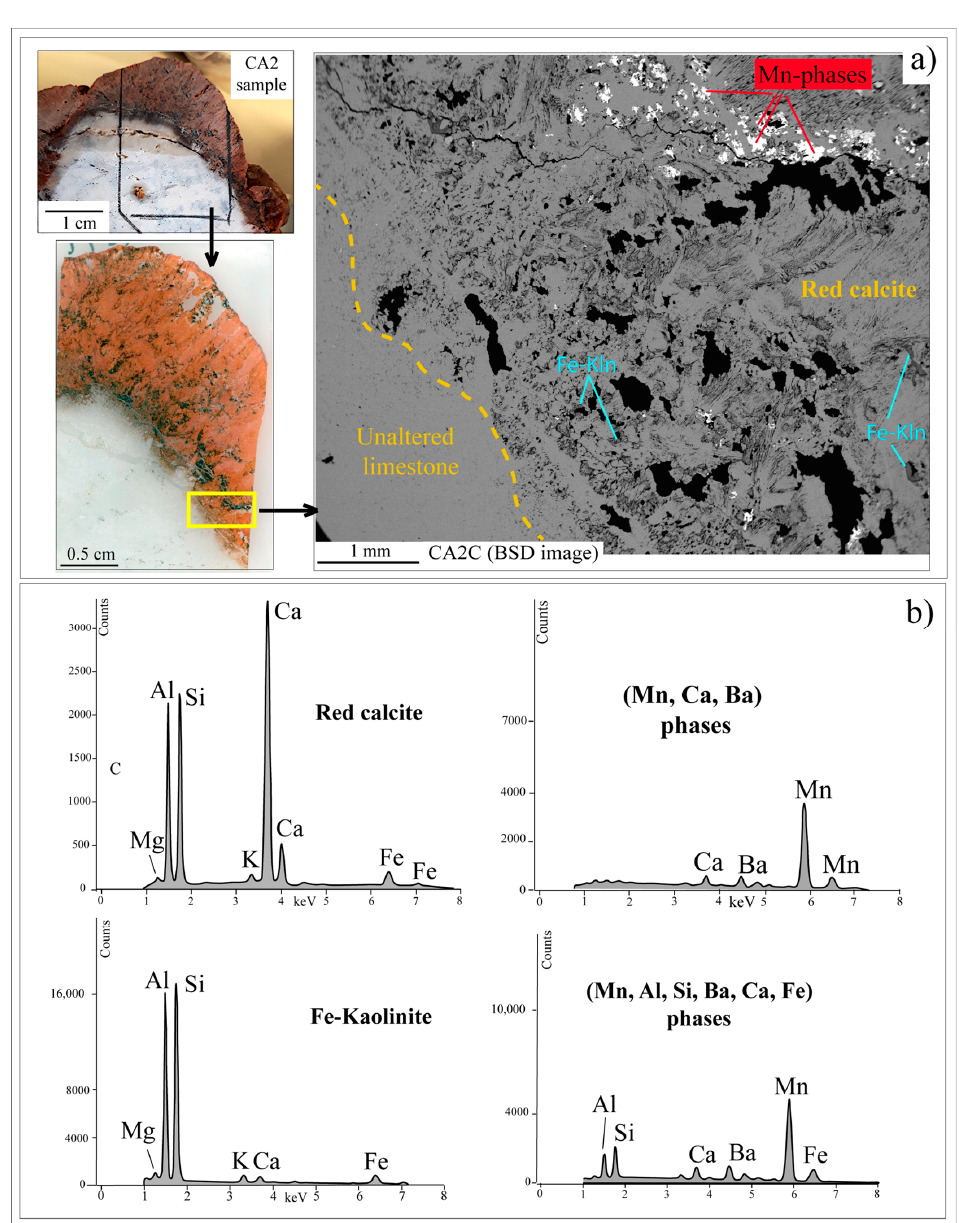
Figure 5. ( a ) Macroscopic image of red incrustation and relative thin section; on the right, a BSD-SEM image; ( b ) Qualitative analyses of some mineral phases in the red incrustation. The centimetric nodules are essentially made up of red calcite with radial growth (Figures 3b and 4c). Small angular grains of quar tz and feldspar are interspersed among calcite fi bers; locally, zircon crystals and some lithic fragments in which a ghost porphyritic texture can be glimpsed (Figure 4c–f), are widespread between them. Some typical nodules were observed under SEM. The structure of red nodules is radial, formed by impure red calcite fi bers, containing Al, Si and Fe, radiating from the core. Among columnar fi brous calcite, detrital minerals such as quar tz , K-Feldspars and zircons are interspersed together with new authigenic phases as anatase, Fe-kaolinite and (Mn, Ba, Ca) phases having spongy or homogeneous textures (Figure 6). The peripheral area of a calcite nodule (BA5 sample) contains a lithic fragment in which (Mn, Ba, Ca) or (Mn, Al, Si, Ba, Ca, Fe) phases, such as those present in the red incrustations, are present.